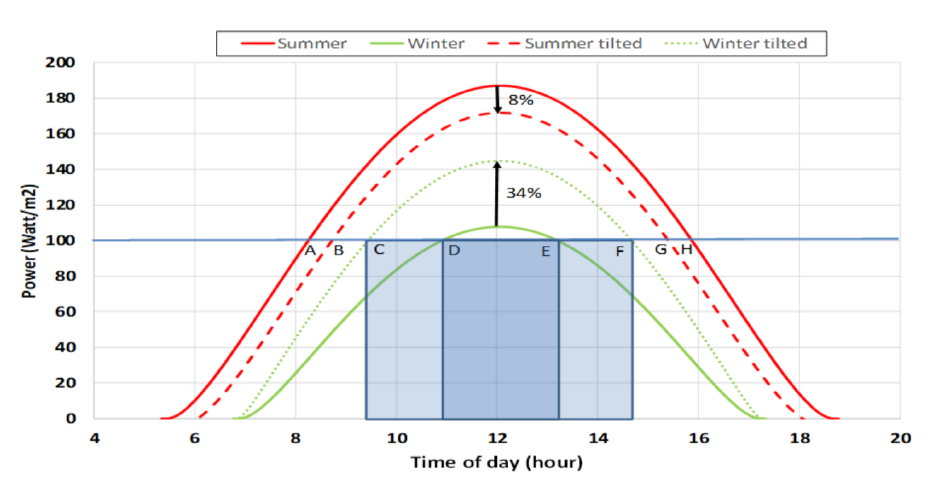
Figure 18. Available electrical power per unit of installed PV panels for a flat-mounted PV array versus a 23.5 ◦ northward-tilted PV array.